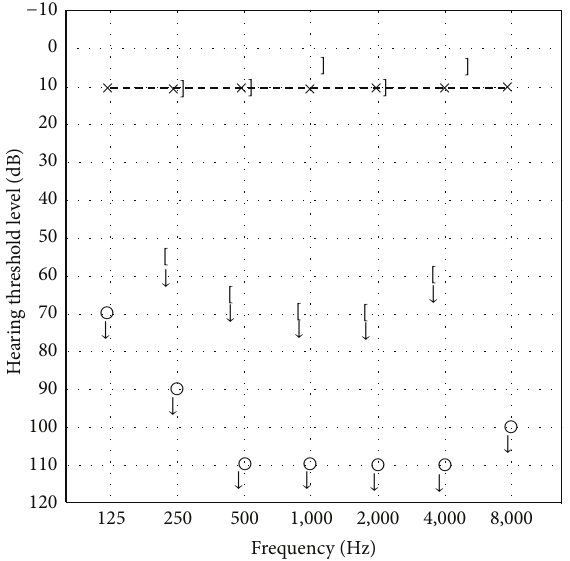
Figure 3: Follow-up audiogram performed 2 years later. Profound sensorineural hearing loss in her right ear had not changed.